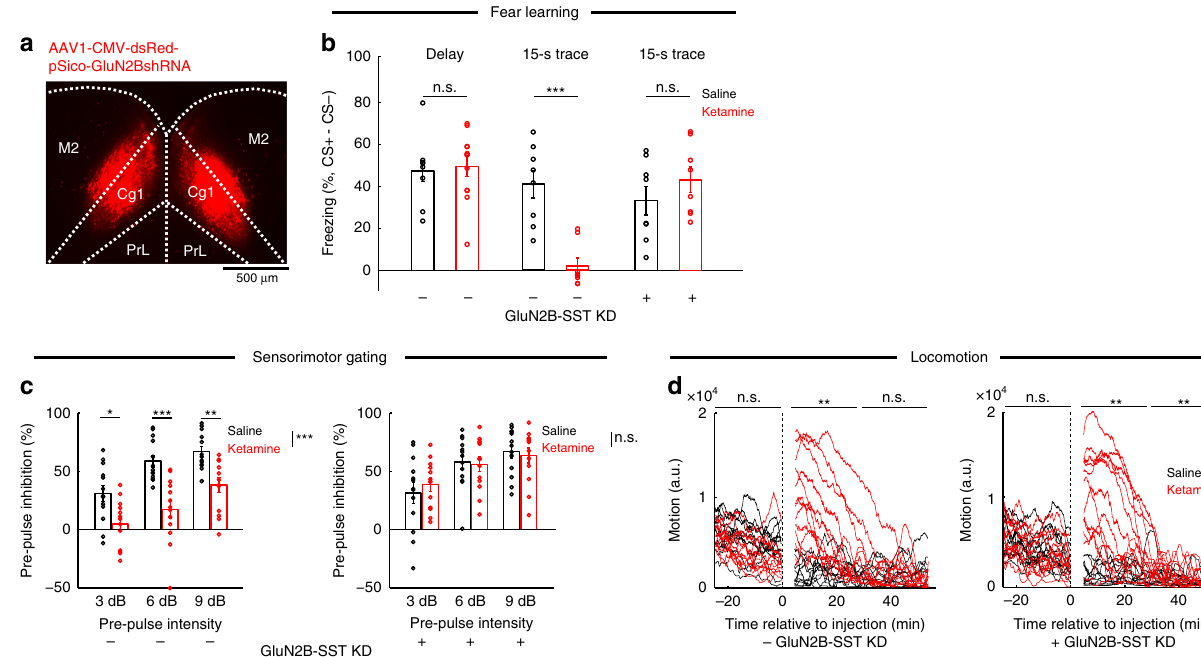
Fig. 6 Chronic downregulation of GluN2B in prefrontal cortical SST interneurons and its behavioral consequences. a Coronal histological section, showing the extent of dsRed expression from bilateral injection of AAV1-CMV-dsRed-pSico-GluN2BshRNA into Cg1/M2 of a SST-IRES-Cre animal. b Fraction of time spent freezing during CS + and trace period (if any), subtracted by that during CS − and trace period (if any), on the testing day. Freezing behavior for control SST-IRES-Cre animals in delay fear conditioning with no trace period (saline: 47 ± 6%, ketamine (10 mg/kg): 50 ± 5%, mean ± s.e.m.; P = 0.5, Wilcoxon rank-sum test; n = 8 and 12 animals for saline and ketamine, respectively), in trace fear conditioning (saline: 41 ± 7%,